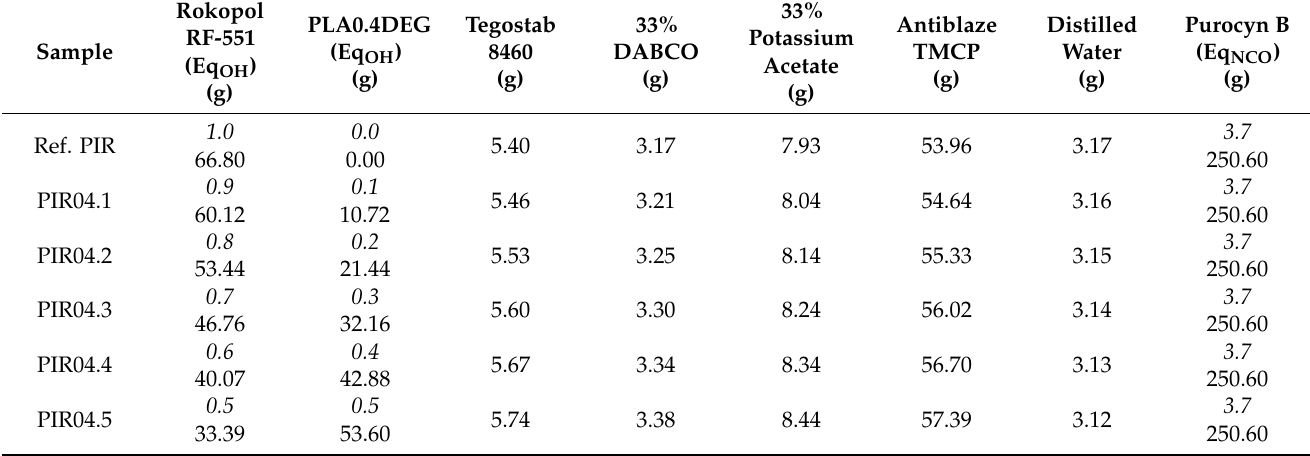
Table 9. Formulation of RPU/PIR foams with PLA0.4DEG